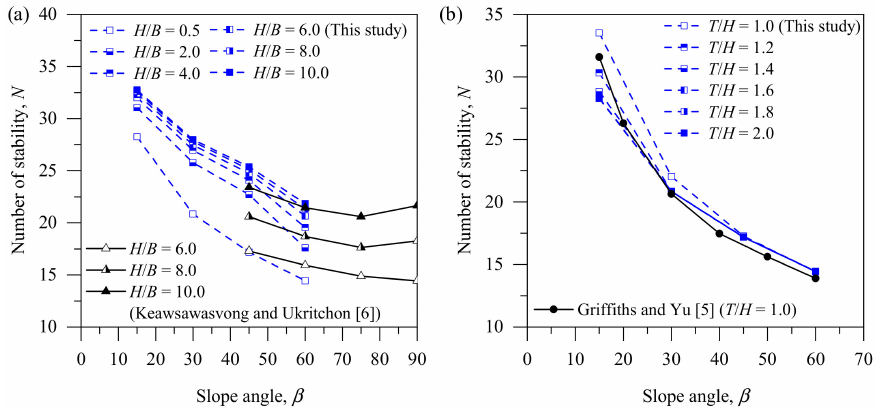
Figure 5. Comparison with published data ( a ) comparison with Keawsawasvong and Ukritchon [6] and ( b ) comparison with Gri ffi ths and Yu